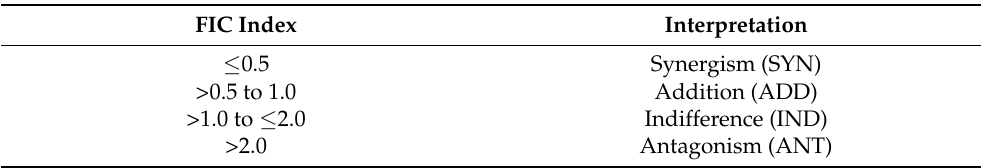
Table 1. Interpretation of the interactions between the two compounds tested using the checkerboard method, based on of the obtained FIC index